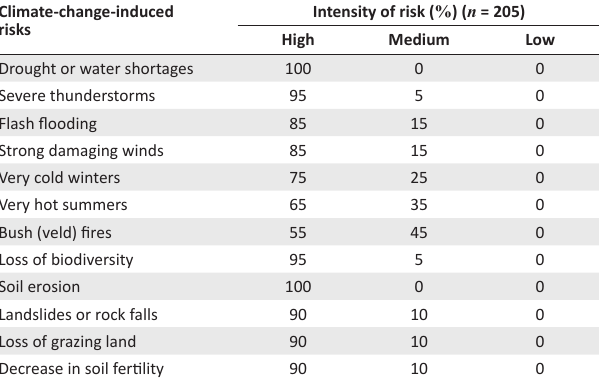
TABLE 1: Phuthaditjhaba respondents’ perceptions of climate-change-induced risks. Climate-change-induced risks